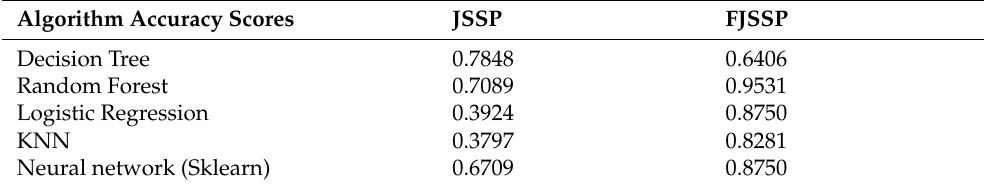
Table 11. Accuracy of classification models for validation datasets. Algorithm Accuracy